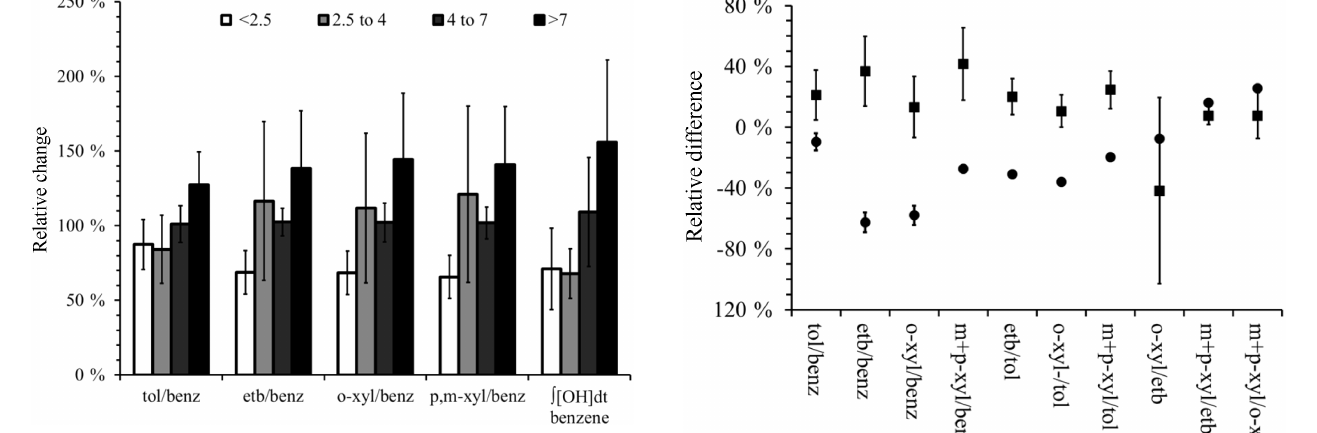
Figure 9. Relative change of VOC concentration ratios and R [OH]d t (PCA) of benzene for different ranges of R [OH]d t (in units of 10 10 smoleculescm − 3 ) derived from the carbon isotope ratio of p,m -xylene. The bars represent the ratio of the mean con- centration ratios for the chosen interval of R [OH]d t over the average for all concentration ratios. The error bars are the relative standard errors of the mean. The range of R [OH]d t for the lowest R [OH]d t bin was chosen to include all R [OH]d t , which are not significantly larger than 0. (95% confidence limit). The other ranges were chosen to include between 8 and 12 data points in each bin.